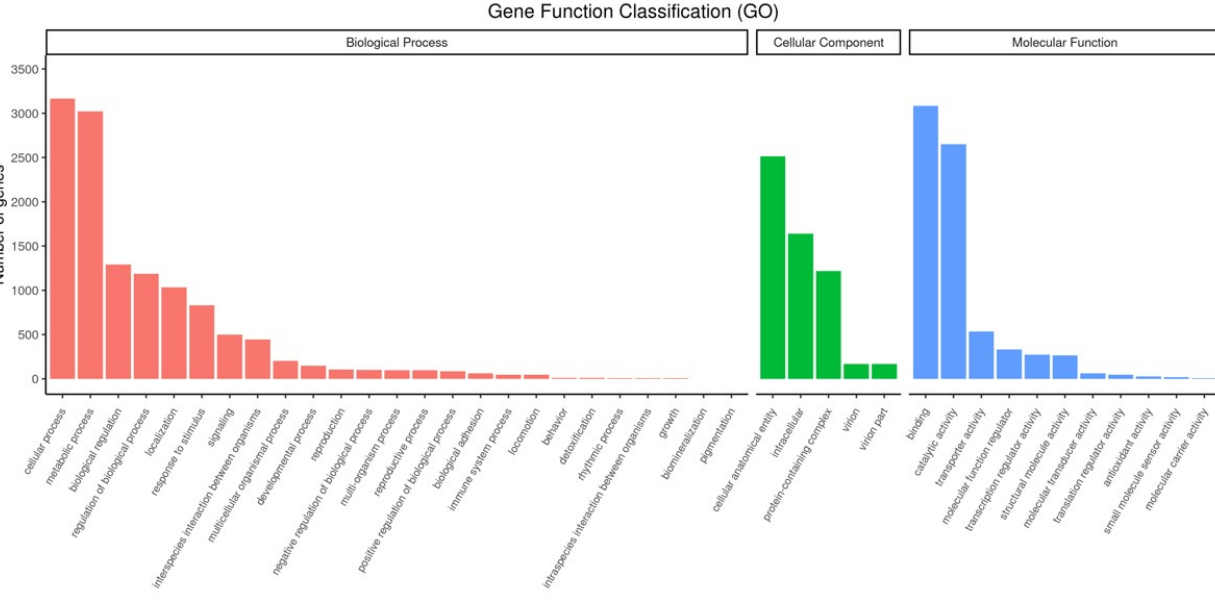
Figure 4. KEGG classification of P. tuoliensis transcriptome into functional groups.